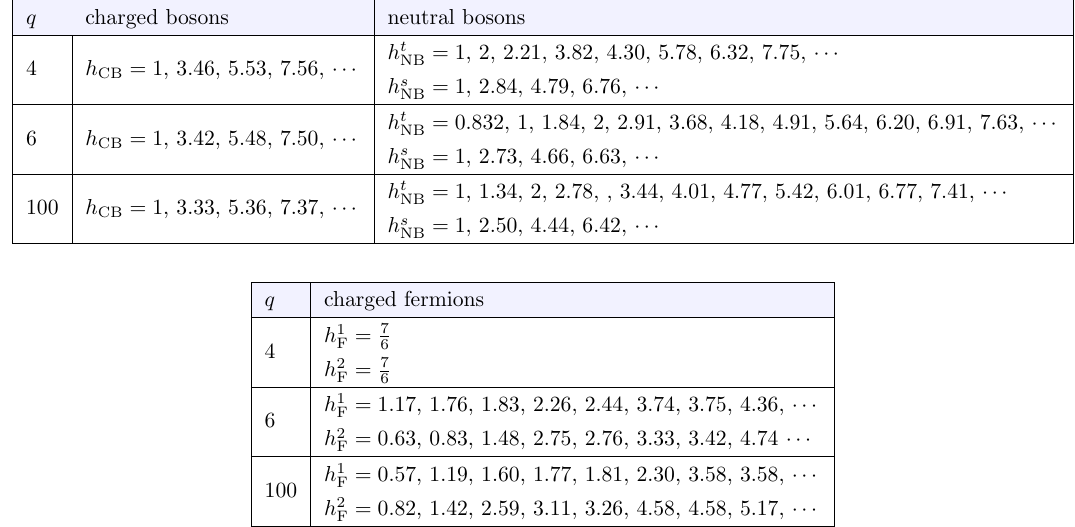
. As we discuss in the main 2 branch of fermions has a pair F + i s 2